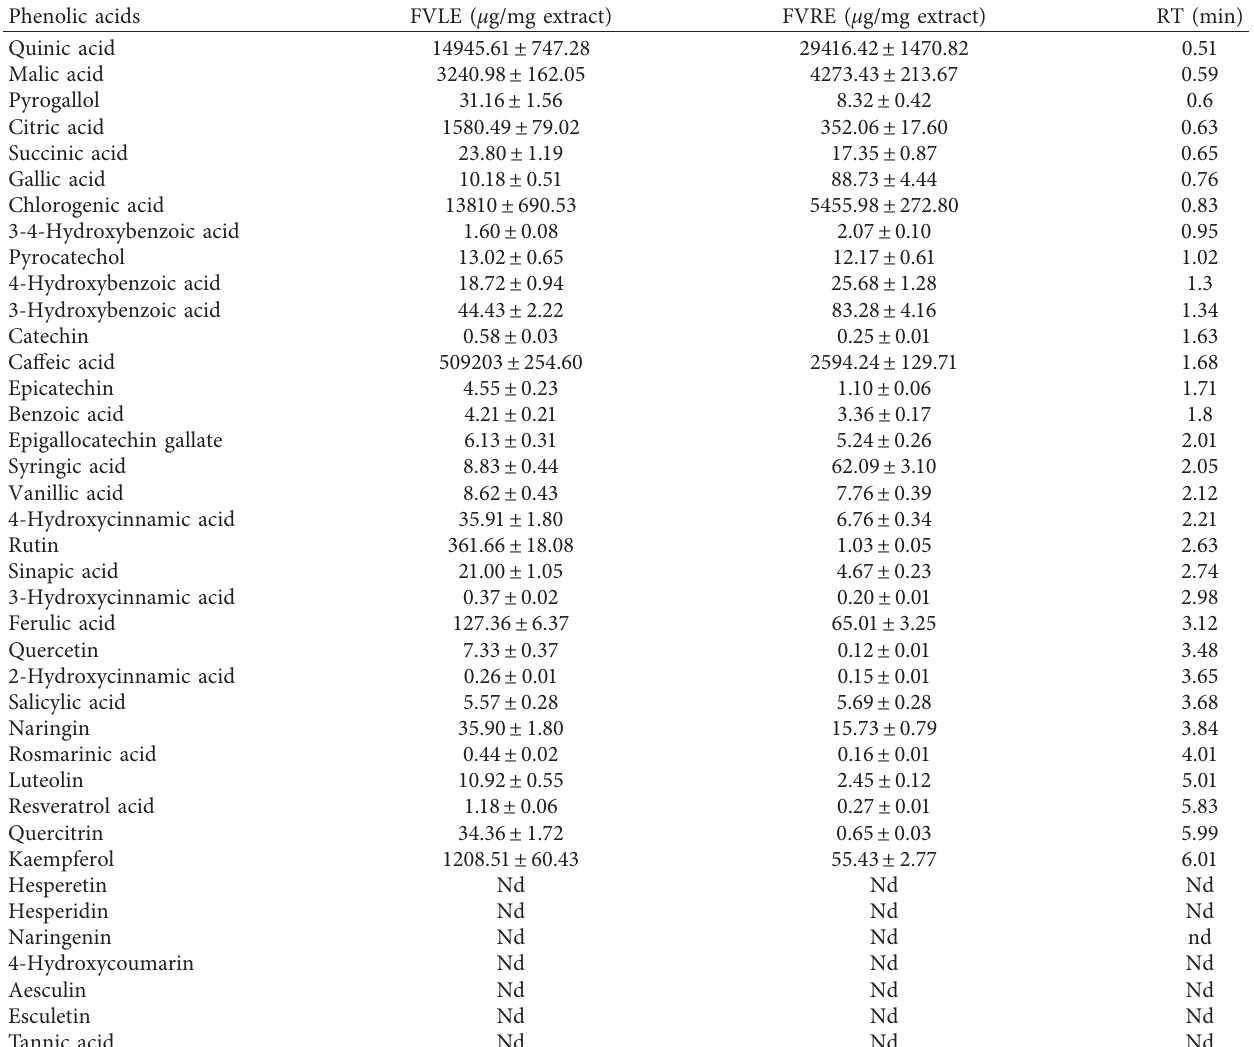
Table 1: Phenolic composition of F. vulgare rootstock and leaf